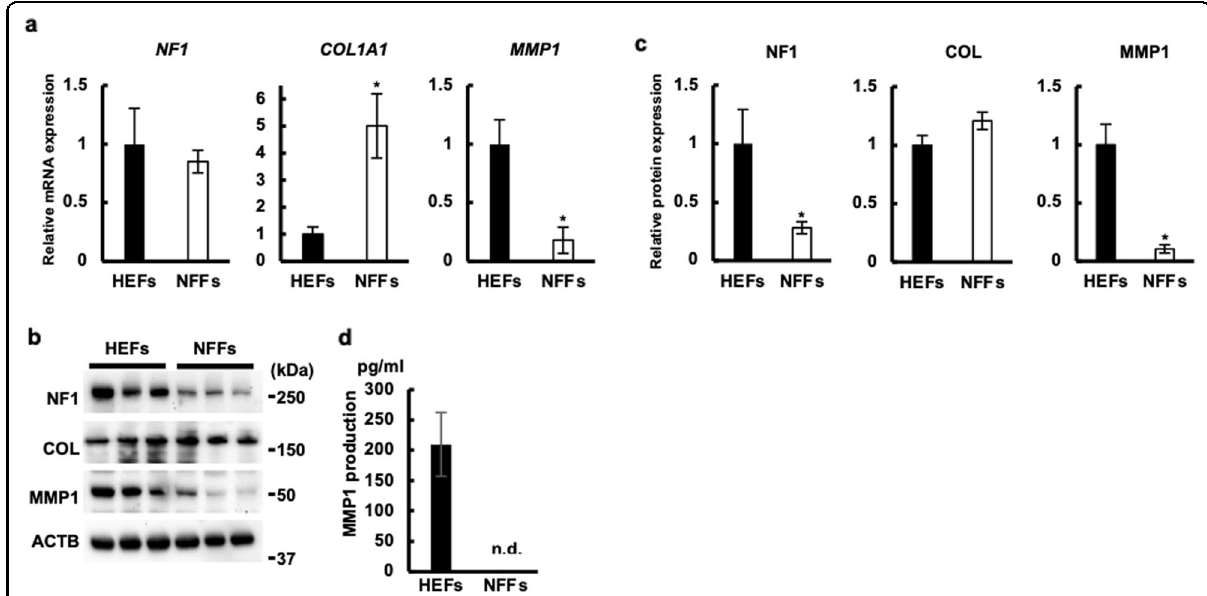
Fig. 2 MMP1 protein expression was downregulated in cultured fi broblasts derived from NF1 patients. Three cell lines of each of HEFs and NFFs were cultured in triplicate wells for 48 h. a Relative mRNA expression of the indicated genes is shown. Black bars represent expression in HEFs and white bars represent expression in NFFs. b , c Expression of the indicated proteins was analyzed by western blot. Representative images of western blot are shown in b and relative expression normalized to β -actin is shown in c . d MMP1 production for 24 h was measured. All cell lines were cultured in triplicate wells and the mean ± SEM of HEFs or NFFs is